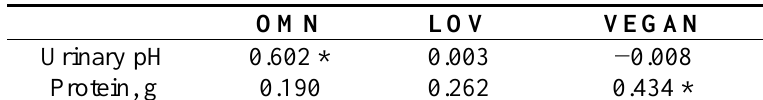
Table 4. Correlation coefficients for urinary pH and protein significantly correlated with BMD in at least one diet group 1